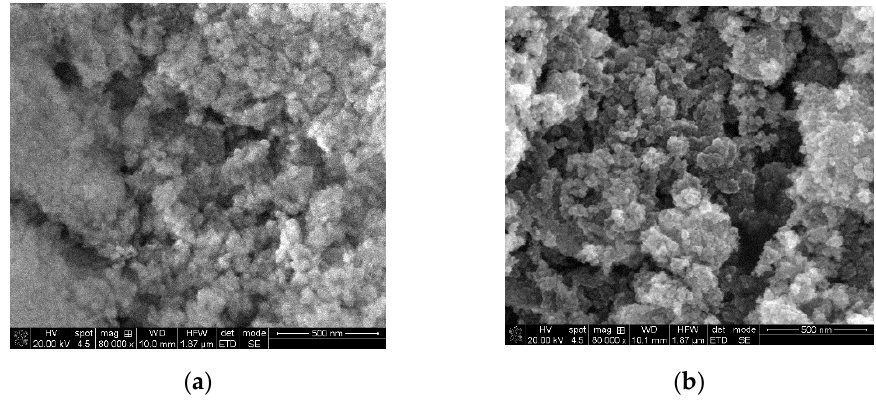
Figure 1. SEM images of powders: ( a ) MgO and ( b ) TiO 2 .